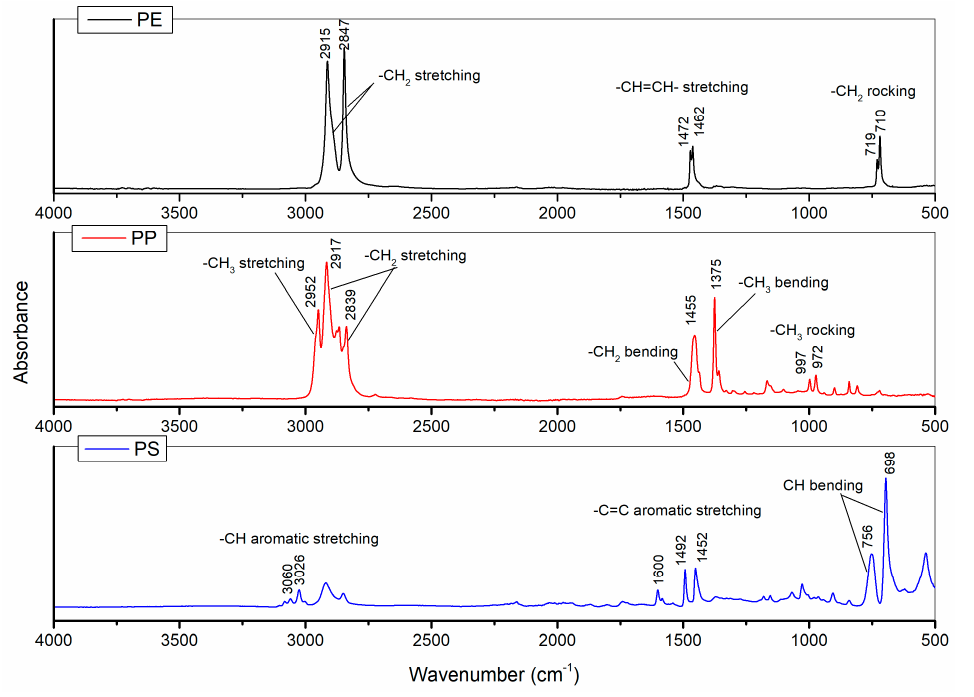
Figure 6. Spectra of pristine PE, PP, and PS particles with characteristics peaks marked for each